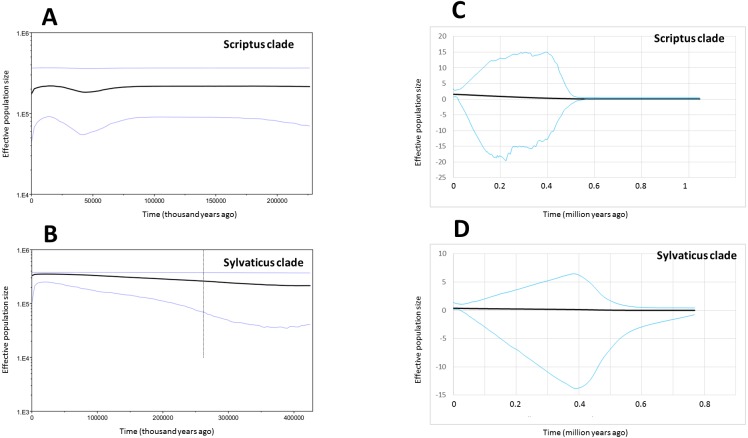
Bayesian Skyline Plots (BSPs) and Extended Bayesian Skyline Plots (EBSPs).(A-B) BSPs represent population size changes over time, inferred with mtDNA and an assumed divergence rate of 0.056 per million years. The X-axes are time in thousands of years. Y-axes are mean effective population sizes log-scale. Solid black lines represent median height and areas between blue lines encompass the 95% highest posterior density (HPD). (C-D) EBSPs represent population size changes over time in two of the mtDNA clades, inferred by mtDNA and nDNA. X-axes are time in millions of years, Y-axes are effective population size divided by generation time.